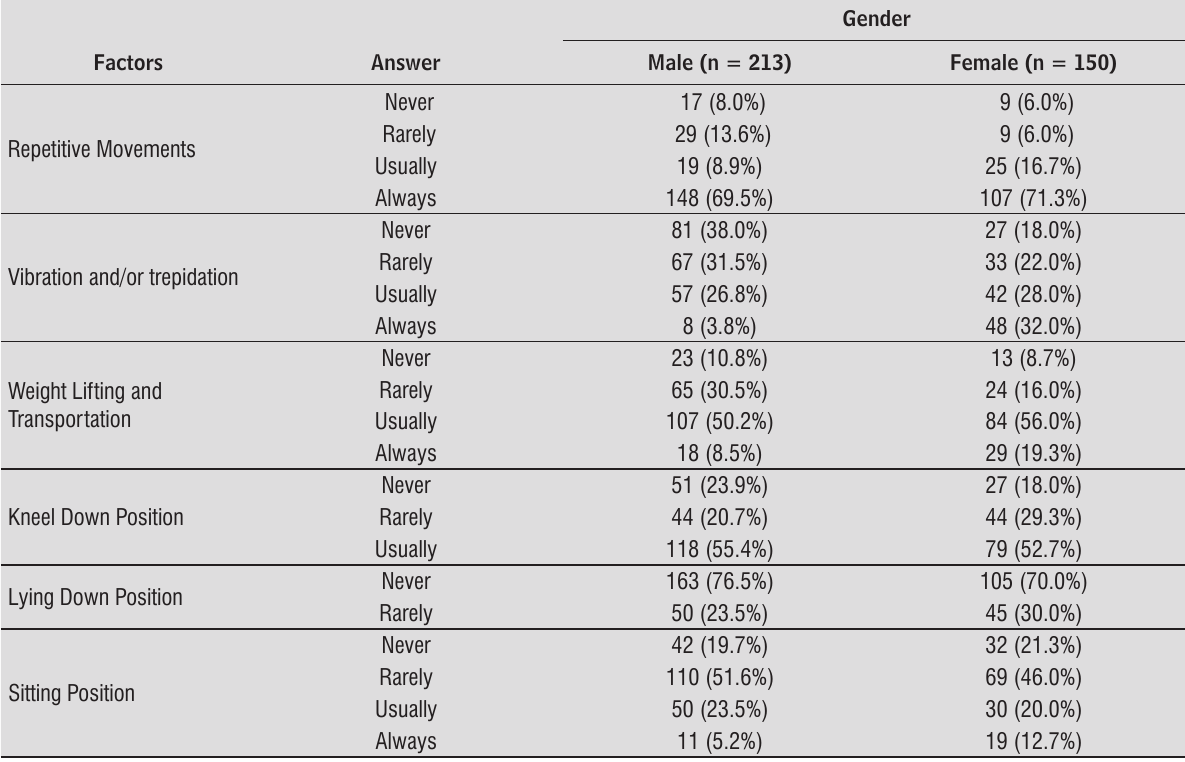
Table 2 - Distribution of absolute and relative frequencies of ergonomic characteristics of the elderly